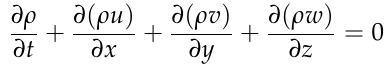
Figure 2. The dimensions of flapping-wing MAV’s parts. Numerical simulation (Moldflow software, Autodesk, San Rafael, CA, USA) was used to simulate warpage of the base, gears, and linkages and to balance the runner of the FW-MAV. The governing equations for mass, momentum, and energy conservation for a non-isothermal, generalized Newtonian fluid are as follows.